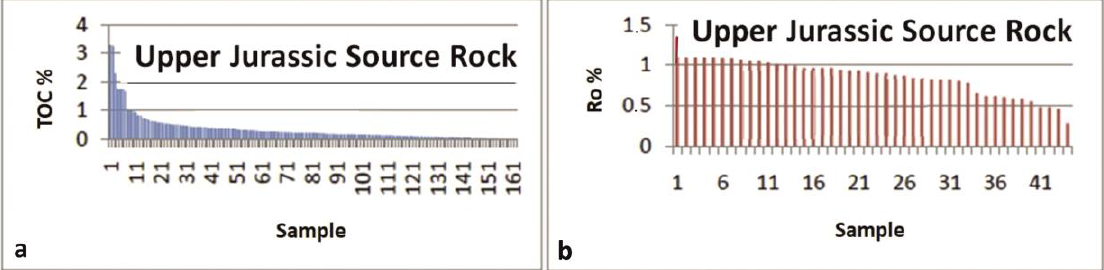
Figure 16. Total organic carbon ( TOC %) ( a ) and vitrinite reflectance (Ro%) data ( b ), respectively, from the source rocks of the Cabaços or Vale Verde Formations, adapted from Pena dos Reis and Pimentel